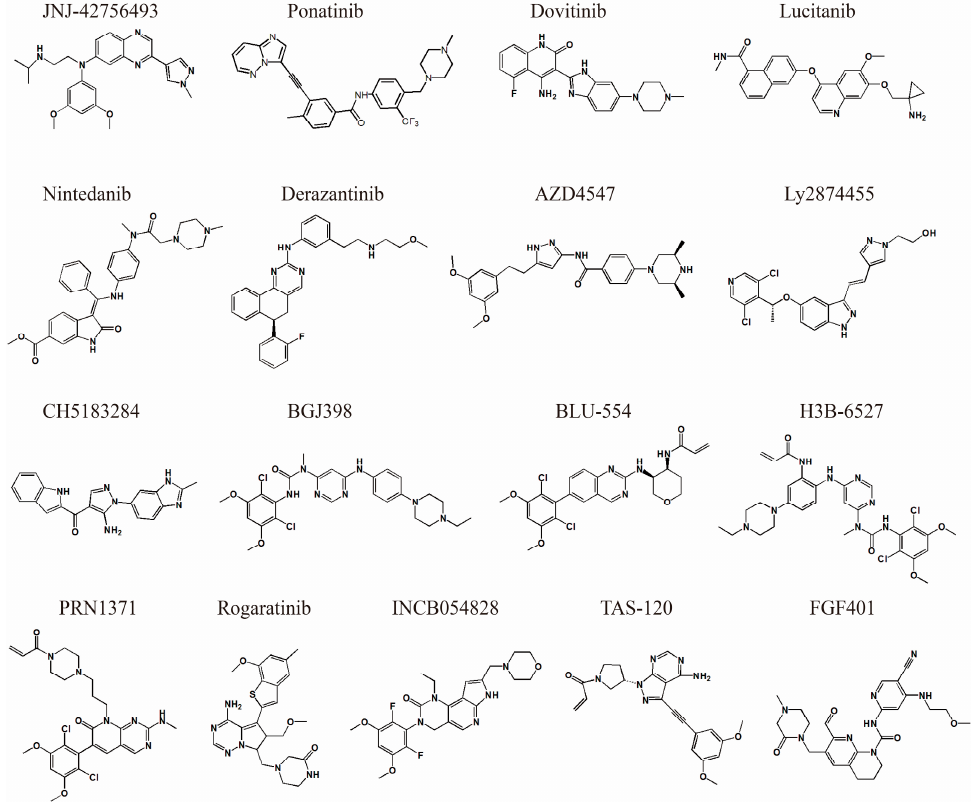
Figure 3. Chemical structure of FGFR small molecule inhibitors.